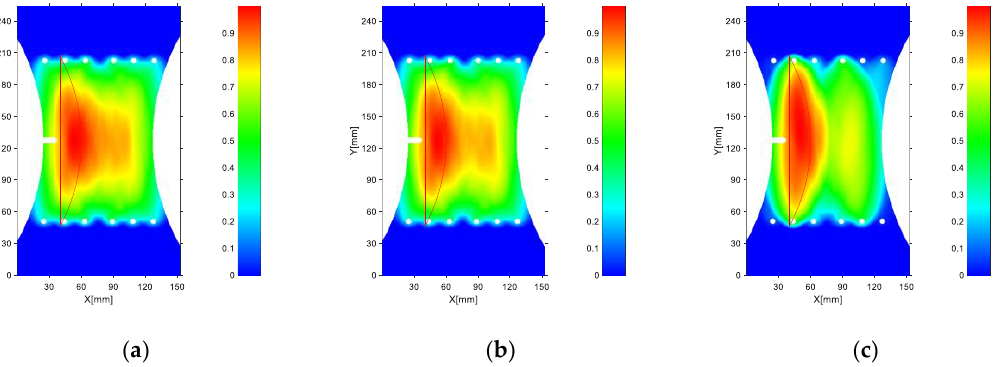
Figure 14. Images for different damage factors at 90,000 fatigue cycles: ( a ) energy damage factor; ( b ) cross-correlation damage factor; ( c ) sparse representation damage factor.